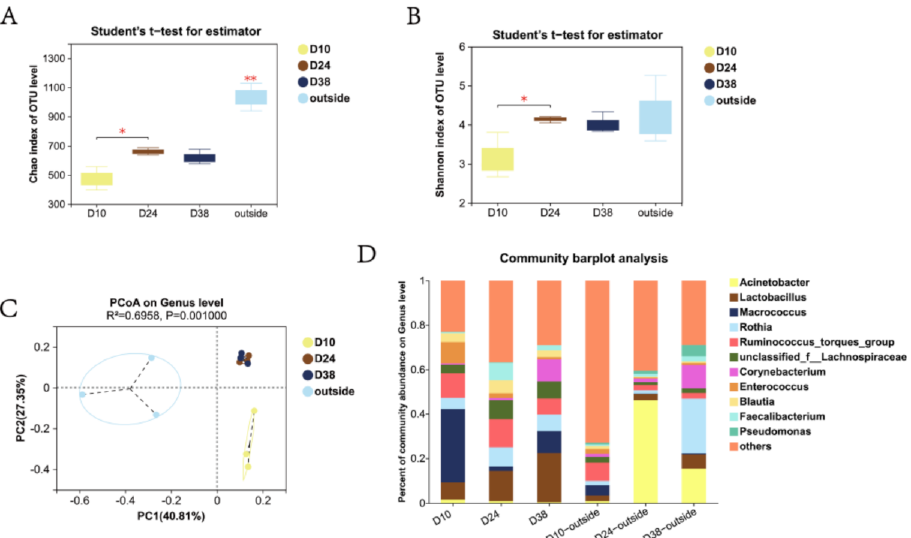
Figure 3. Characteristics of airborne bacterial communities inside and outside the house. ( A , B ) represent the alpha diversity of the community: ( A ) Chao index; ( B ) Shannon index; ( C ) PCoA analysis of community structure; ( D ) relative abundance at genus level.* p < 0.05, ** p <